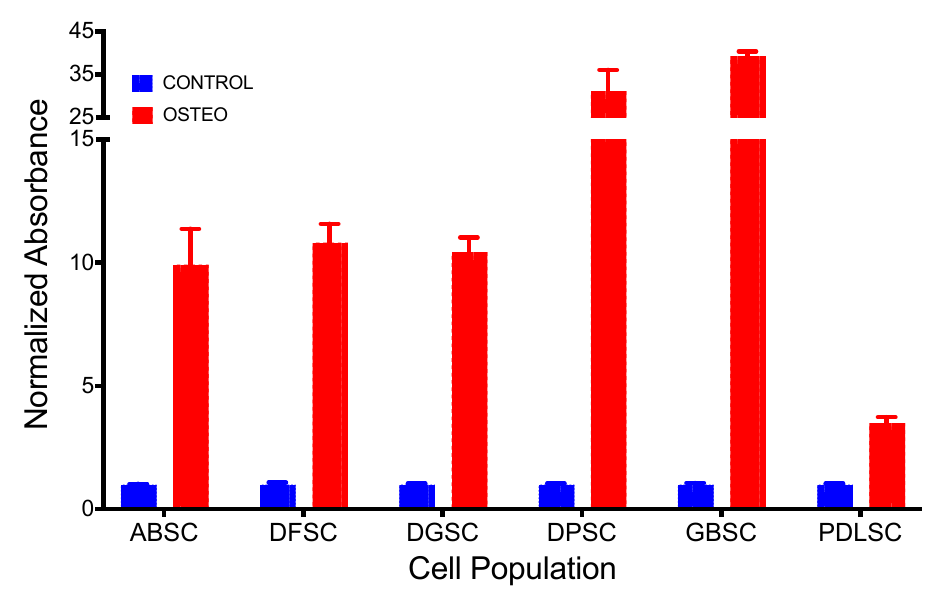
Figure 5. Quantification of alizarin red staining (normalized to control) demonstrating a higher and significant detection in cultures induced to osteoblastic differentiation compared to controls ( p < 0.001; t test). Data are shown as mean(SD).